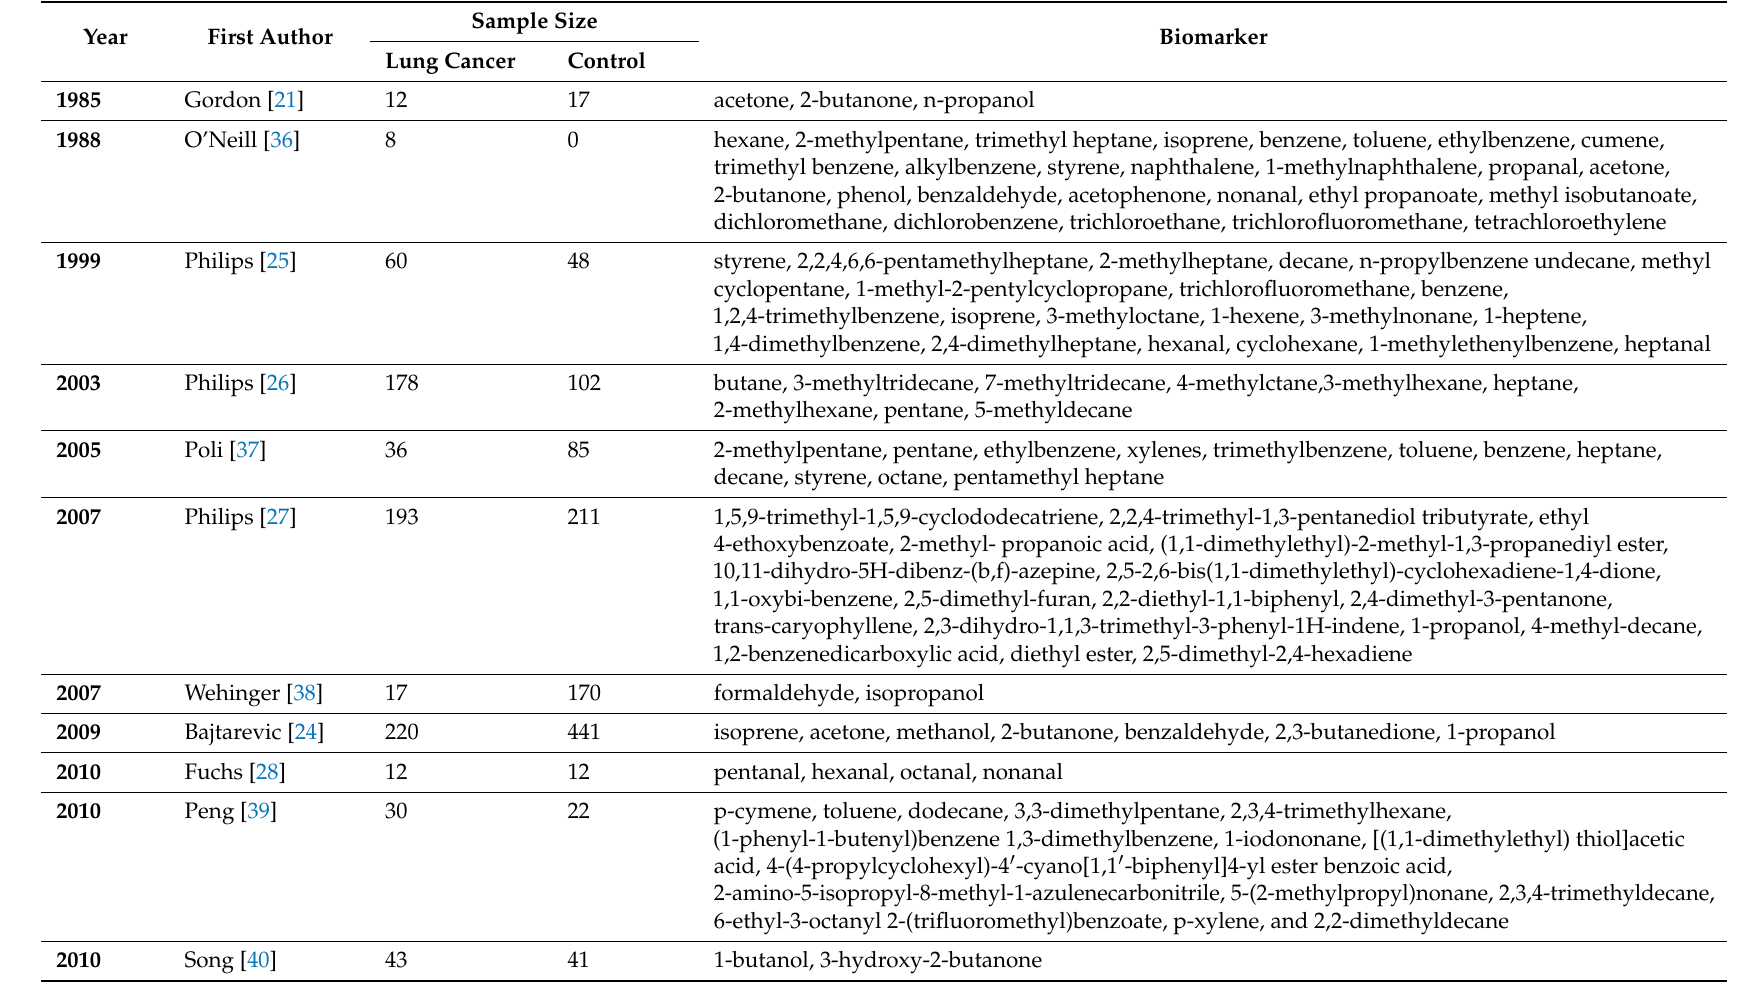
Table 1. Identified volatile biomarkers of lung cancer through breath (Chronological